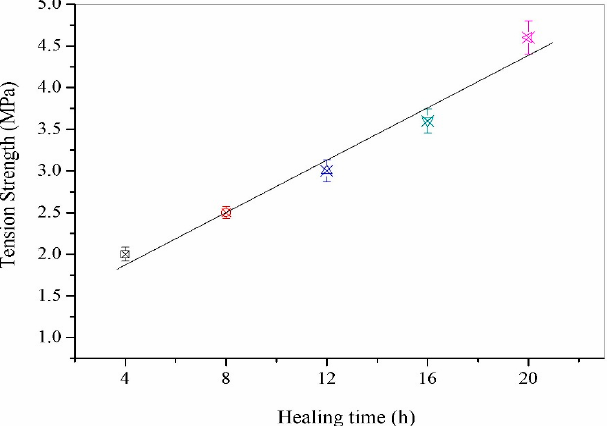
Figure 8. Tension strength values of microcapsules/bitumen samples (microcapsules sample-5, 3.0 wt. %, 20 μ m) during a fracture-healing process under 10 °C with healing time of: 4 h, 8 h, 12 h, 16 h and 20 h.